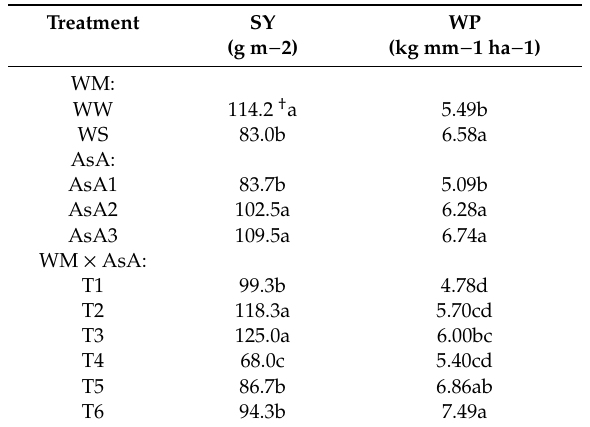
Table 7. The e ff ect of water management (WM) and ascorbic acid (AsA) on seed yield (SY) and crop water productivity (WP) of common bean plants.